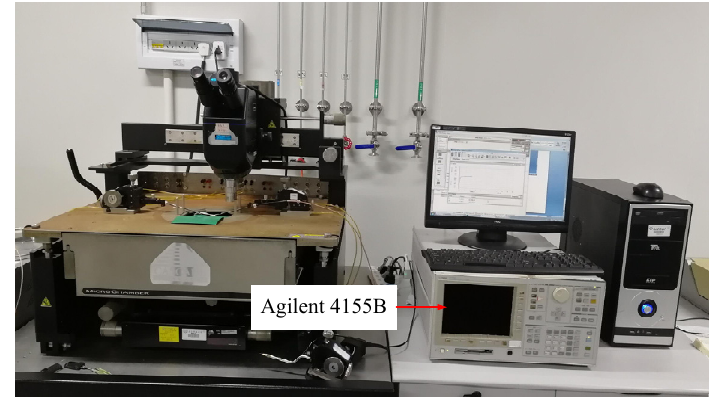
Figure 4. The I-V static parameter test system for diode.